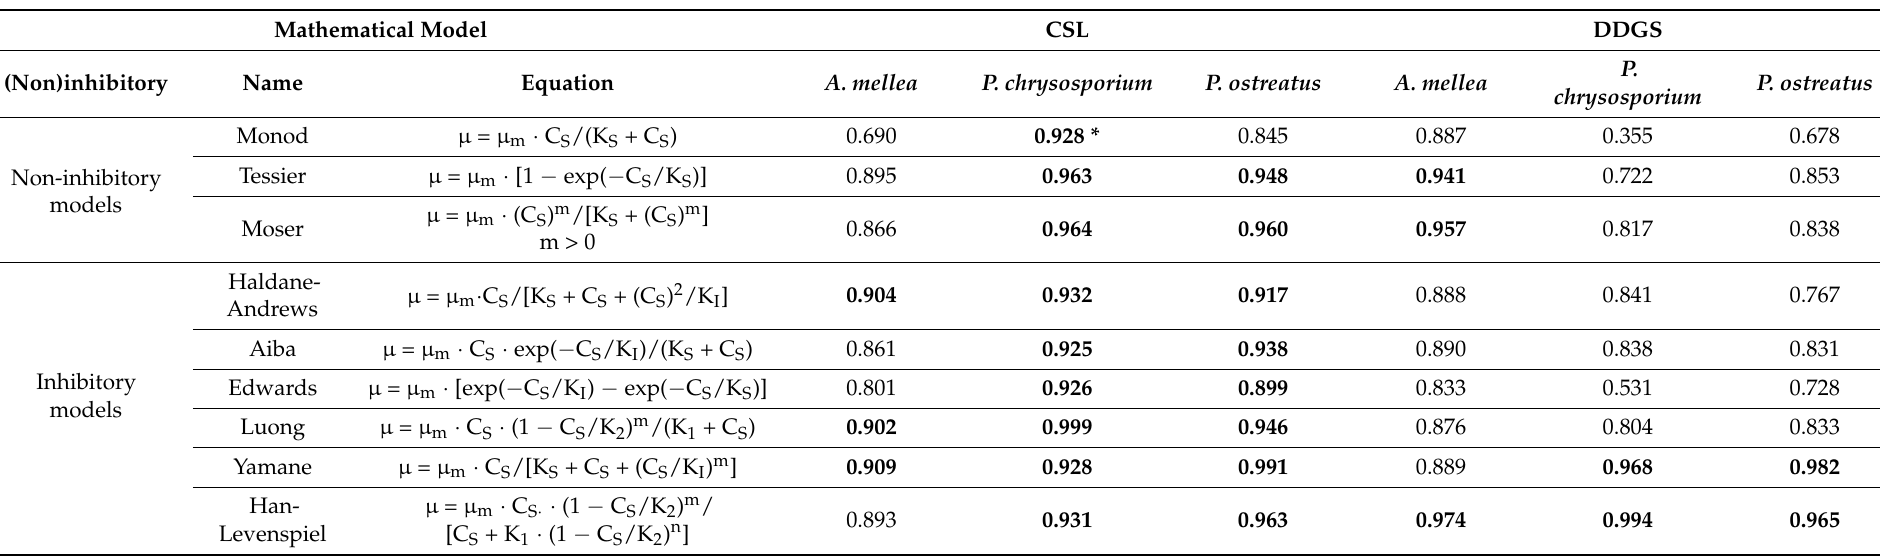
Table 5. Mathematical models for growth curves of A. mellea , P. chrysosporium , and P. ostreatus in CSL and DDGS one-component media and corresponding determination